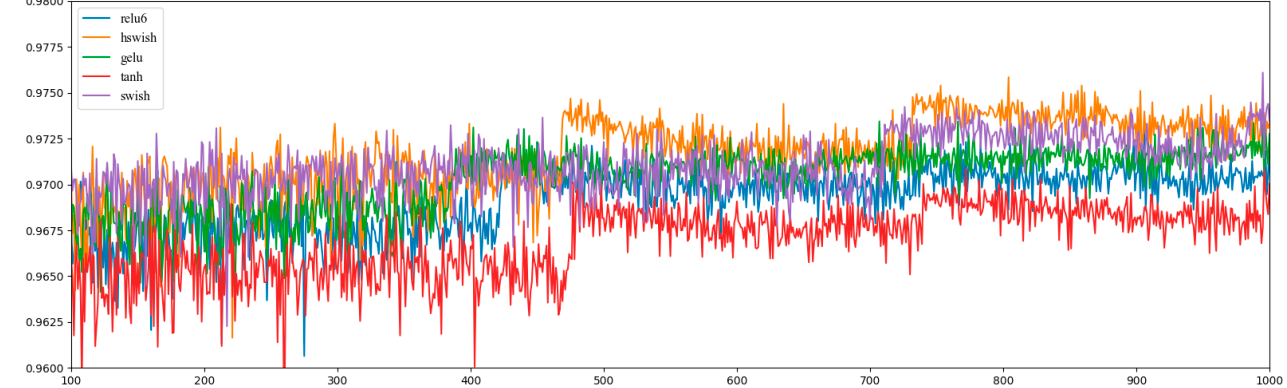
Figure 15. Convergence curves of different activation functions. Note: the above convergence curves were all measured on the fully connected model proposed in Section 2.2.3, and the range shown in the figure is 100 to 1000 epochs.